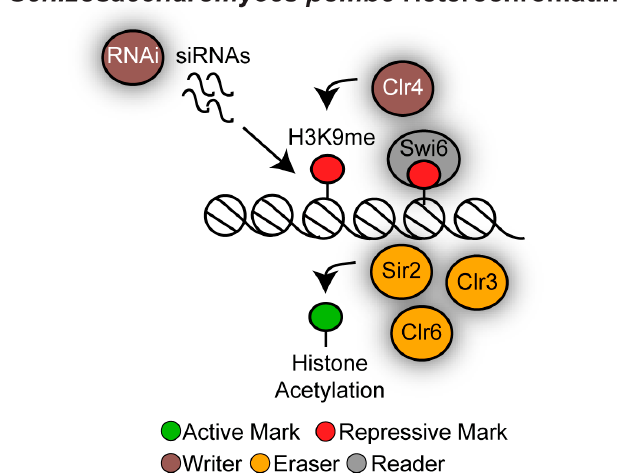
Figure 5. Heterochromatin structure in Schizosaccharomyces pombe . The RNAi machinery seeds heterochromatin assembly by recruiting the protein complex containing the writer histone-H3K9 methyltransferase Clr4. H3K9me is a binding site for chromodomain reader proteins such as Swi6. The histone deacetylases Sir2, Clr3 and Clr6 maintain the hypoacetylated histone